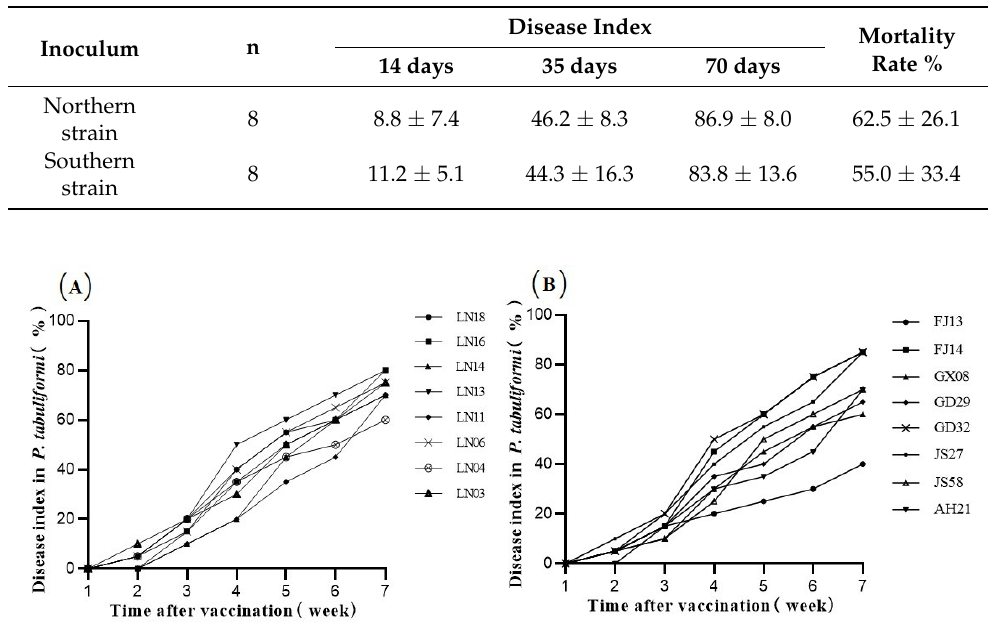
Figure 6. The pine wood nematode (PWN) Bursaphelenchus xylophilus disease index in P. tabuliformis after inoculation with PWN strains. Sixteen reference numbers represent sixteen PWN isolates from different regions. ( A ) Disease index of the 8 northern strains. ( B ) Disease index of the 8 southern strains.